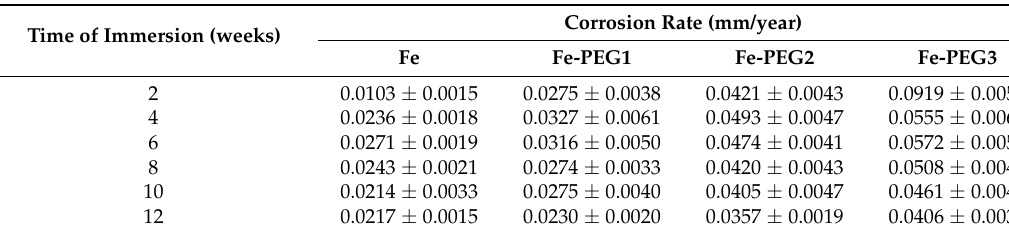
Table 4. The values of static corrosion rate for each material immersed in Hanks’ solution for 2, 4, 6, 8, 10, and 12 weeks.